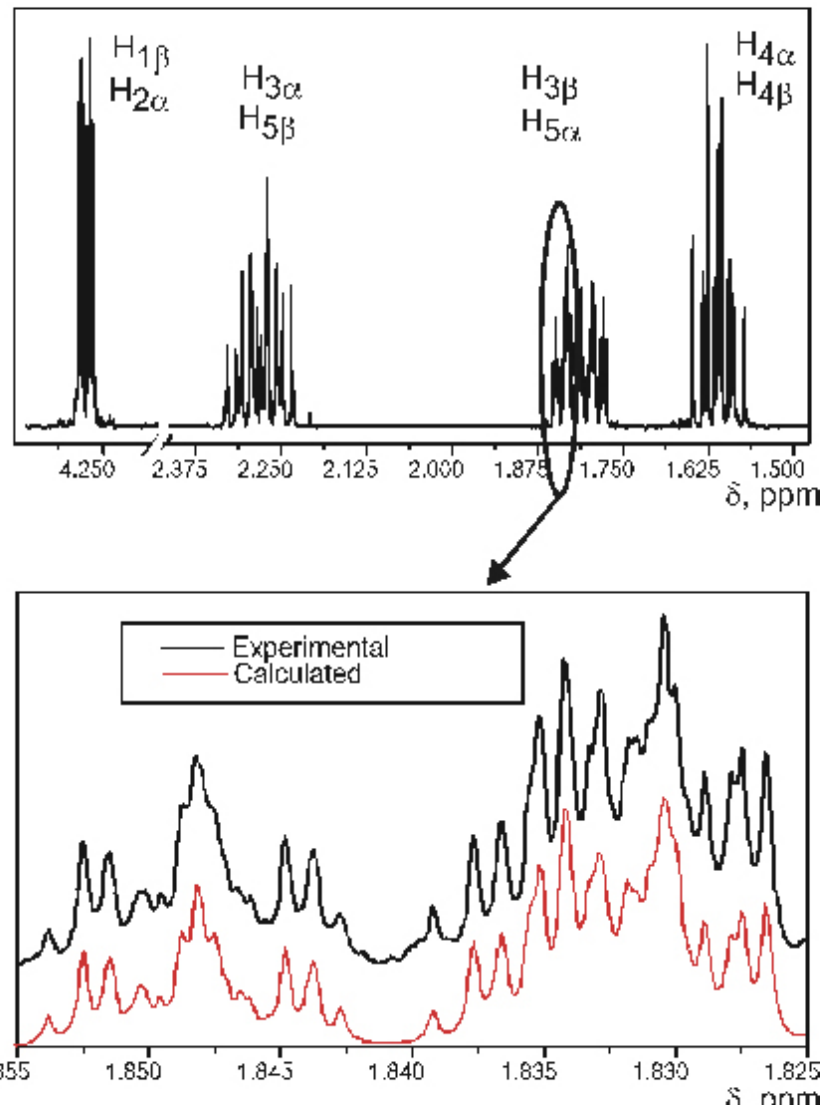
Figure 2. Experimental (top) 1 H-NMR spectrum of trans-1,2-dibromocyclopentane (2M solution in CD CN, 303K, 400 MHz) and an inset (bottom) of experimental (black) and calculated (red) 3